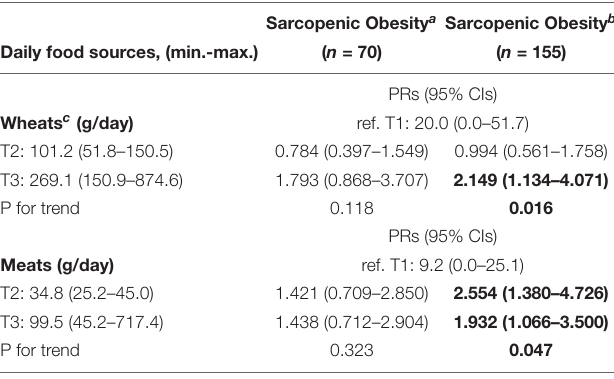
TABLE 4 | Adjusted prevalence ratios (PRs) in multivariate logistic regression between daily food sources and Sarcopenic Obesity. Sarcopenic Obesity a Sarcopenic Obesity b Daily food sources,